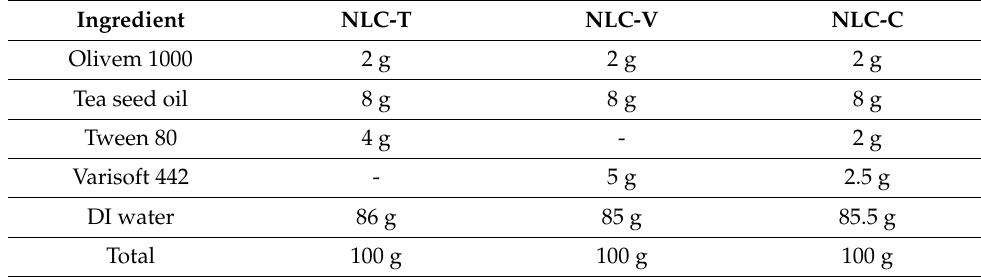
Table 1. Composition of three NLC formulations containing tea seed